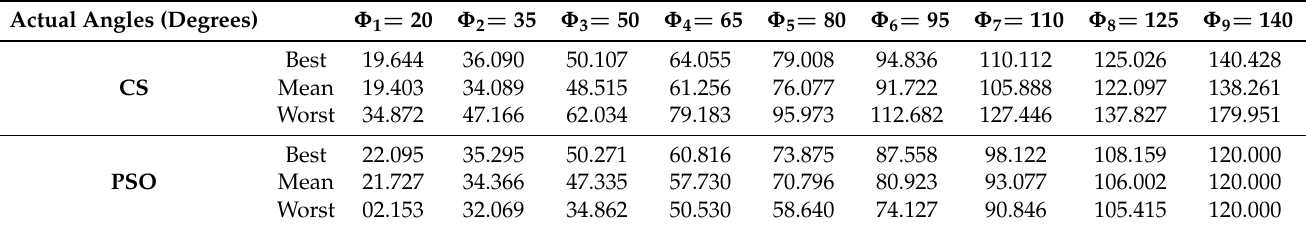
Table 5. Calculation of accuracy for nine targets at − 5 dB